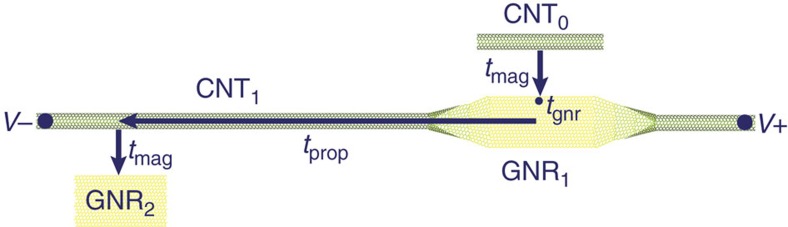
Analysis of switching and propagation delay.Following a switch in the current through CNT0 at a time t=0, the magnetic field at the edge of GNR1 switches at t=tmag, the resistance of GNR1 switches at t=tmag+tgnr and the current through CNT1 switches at t=tmag+tgnr+tprop. This marks the end of one complete switching and propagation cycle, and is immediately followed by the switching of GNR2.